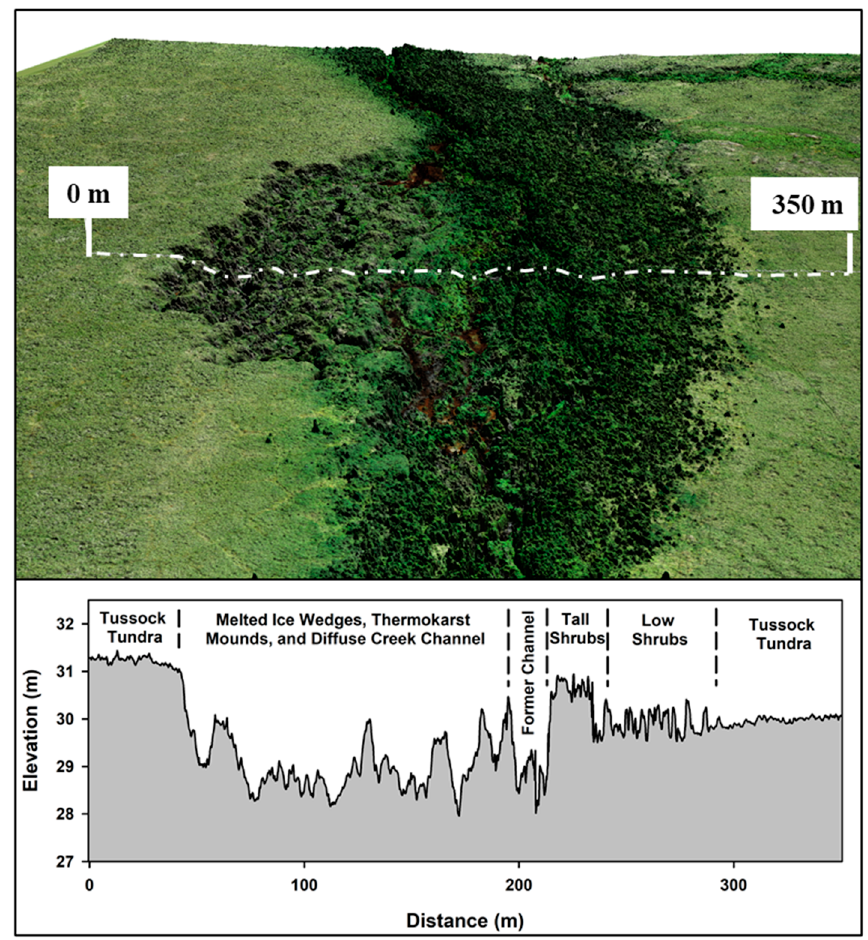
Figure 11. A 15 cm resolution, colorized digital surface model derived from the UAS survey data ( top ) and extracted elevation profile ( bottom ) for the portion of Swan Lake Creek most heavily disturbed by the beaver-induced permafrost degradation. Numerous features are evident in the elevation profile data, from left to right—gently sloping tussock tundra that is underlain by ice rich permafrost; the area of beaver-induced permafrost degradation showing melted ice wedges, intervening thermokarst mounds, and the now diffuse creek channel; tall shrubs; low shrubs; and gently sloping tussock